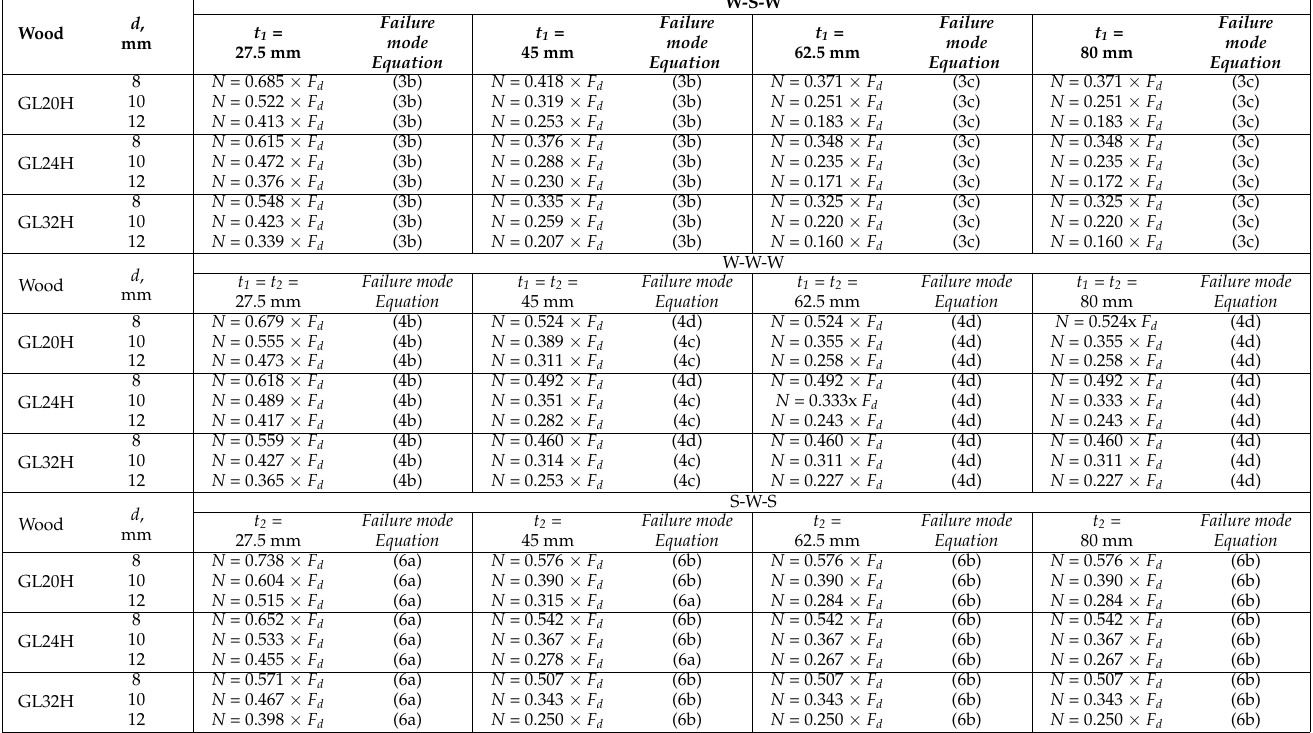
Table 5. Parametric study in three types of timber